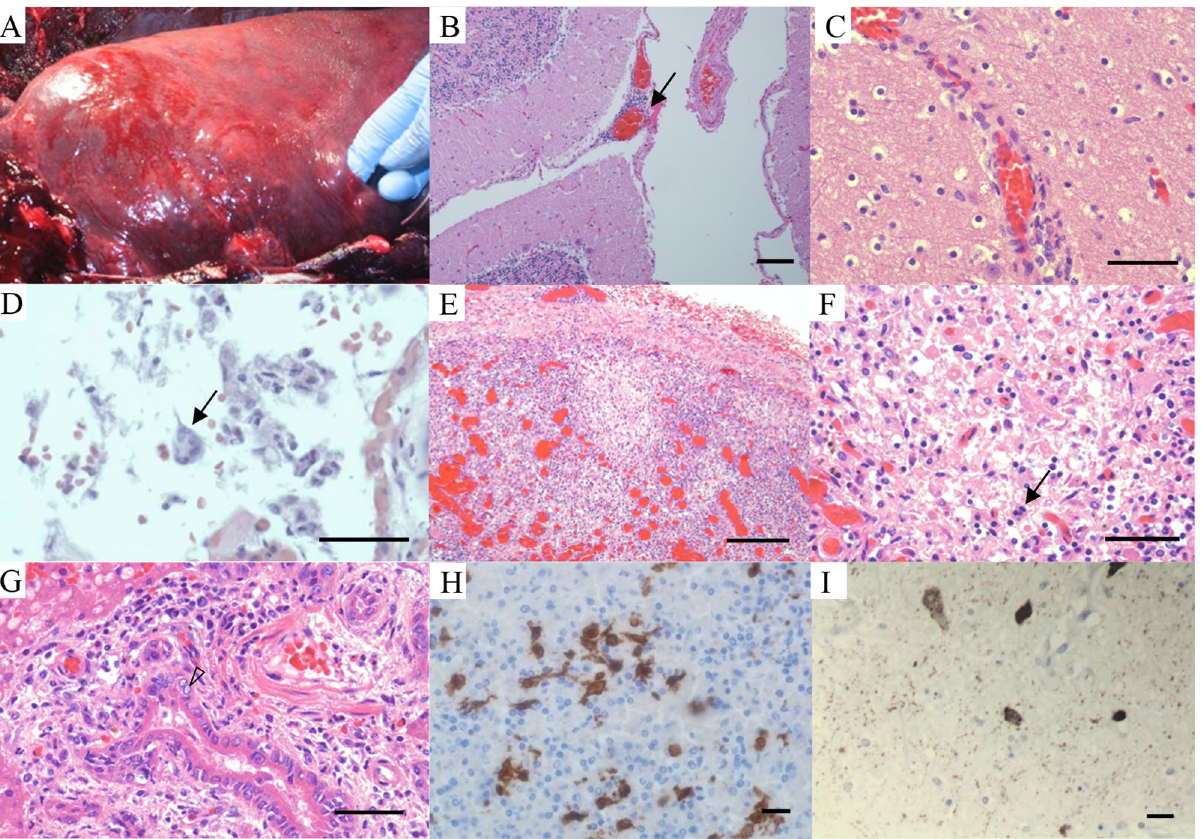
Figure 2. ( A ) Left lung. There are firm nodules present throughout the pulmonary parenchyma. The nodules may also be related to parasitism; ( B ) Meninges. H&E stain: Lymphocytic infiltrates within the meninges (arrow). Bar = 100 µm; ( C ) Cerebrum. H&E stain: Perivascular lymphocytic cuffing. Bar = 2 mm; ( D ) Lung. H&E stain: Alveolar spaces contain sloughed Type II pneumocytes, erythrocytes and rare syncytial cells (arrow). Vessels are congested. Bar = 500 µm; ( E ) Lymph node. H& E stain: Lymphoid follicle depletion. Bar = 2 mm; ( F ) Lymph node. H&E stain: Germinal center necrosis. Syncytium (arrow). Bar = 500 µm; ( G ) Bile duct.